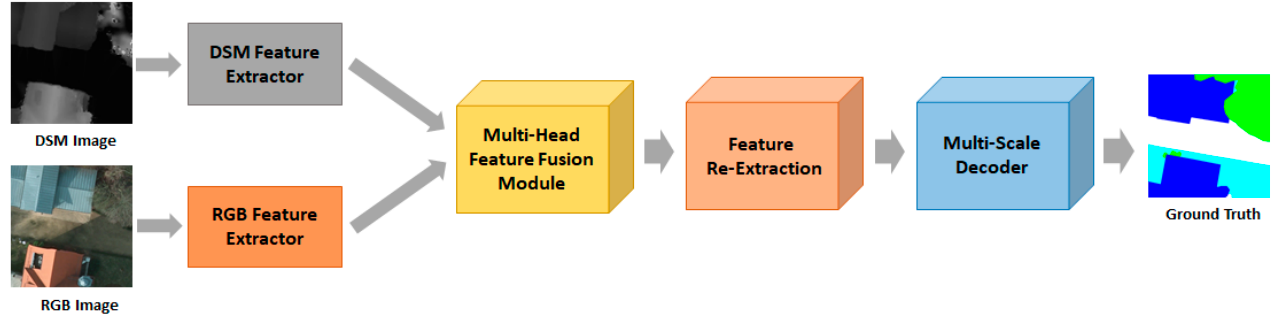
Figure 2. A flowchart of the MFTransNet.